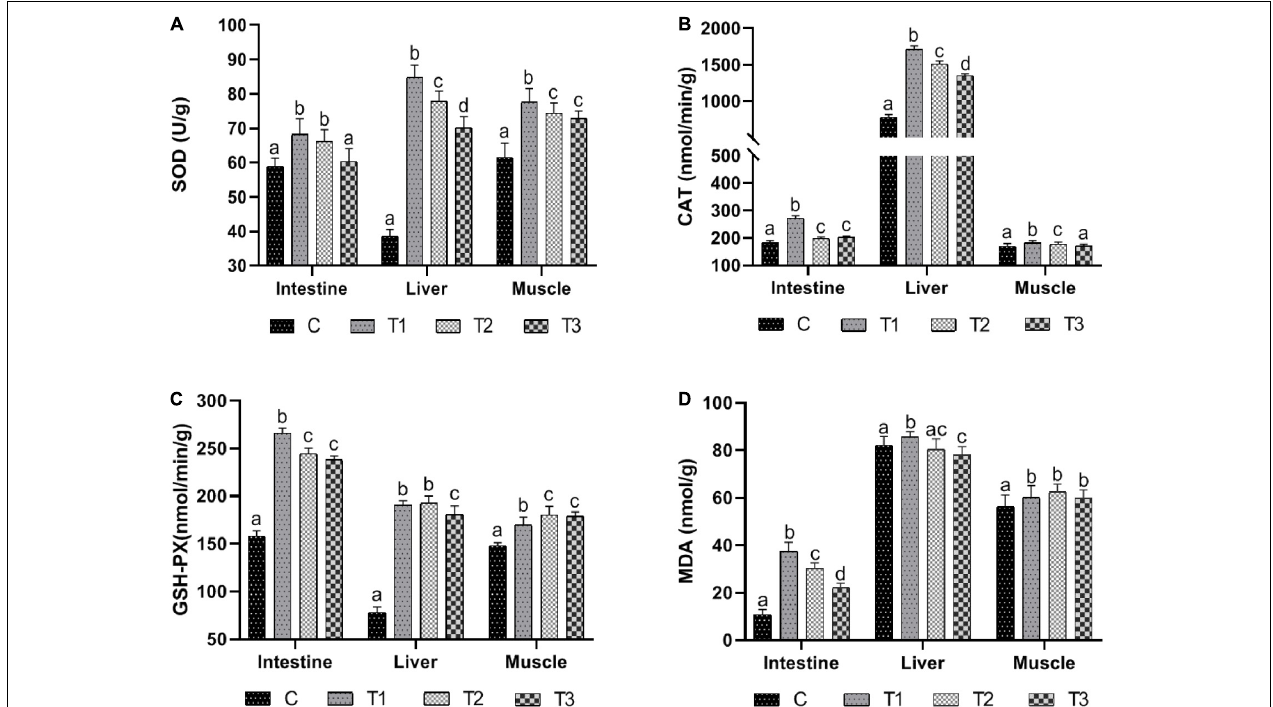
FIGURE 1 | The antioxidant enzymes activities and MDA content in large yellow croaker after temperature variation. (A–D) Represents the SOD activity, the CAT activity, the GSH-PX activity and the MDA content, respectively. Columns with different letters are significantly different ( P < 0.05). C represents the control group where the fish were kept at 12 ◦ C at the beginning of the experiment; T1 represents the group sampled on the first day when the water temperature reached 8 from 12 ◦ C; T2 represents the group sampled when the fish had been kept at 8 ◦ C for 3 days; T3 represents the group sampled when the water temperature was increased to 12 from 8 ◦ C. The data are presented as the mean ± SD ( n =